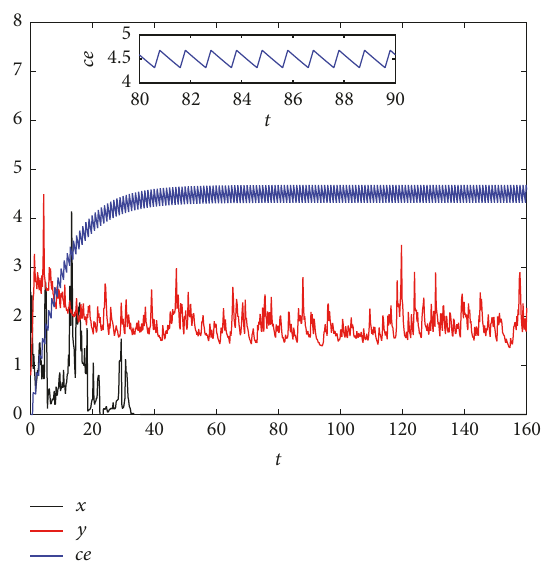
Figure 1: Sample paths of 𝑥(𝑡) and 𝑦(𝑡) with initial conditions 𝑥(0) = 2.5 and 𝑦(0) = 0.8 .